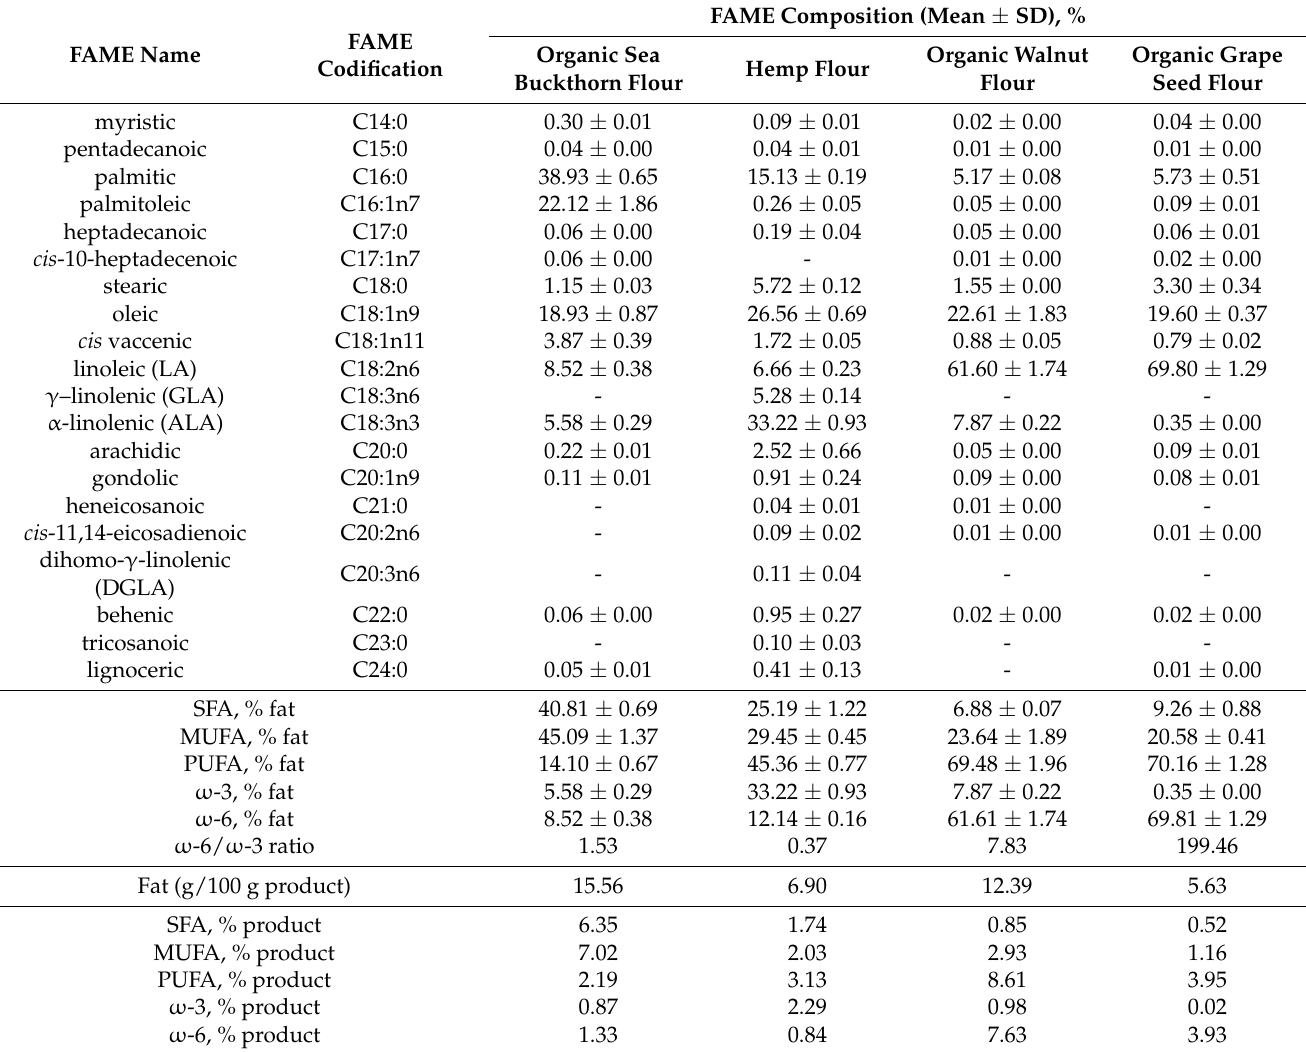
Table 2. Fatty acid methyl esters content of flour